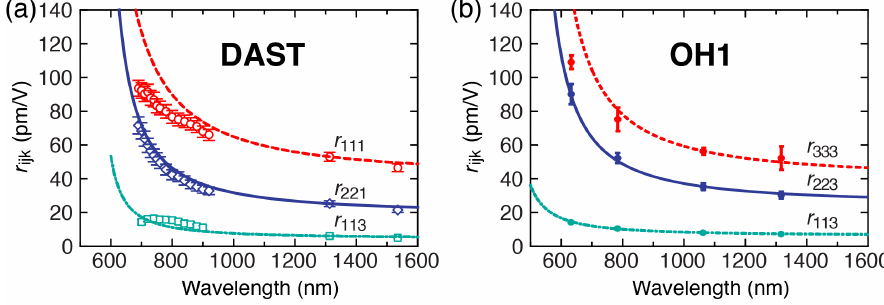
Figure 6. Dispersion of the largest electro-optic coefficients in ( a ) DAST [22,23] and ( b ) OH1